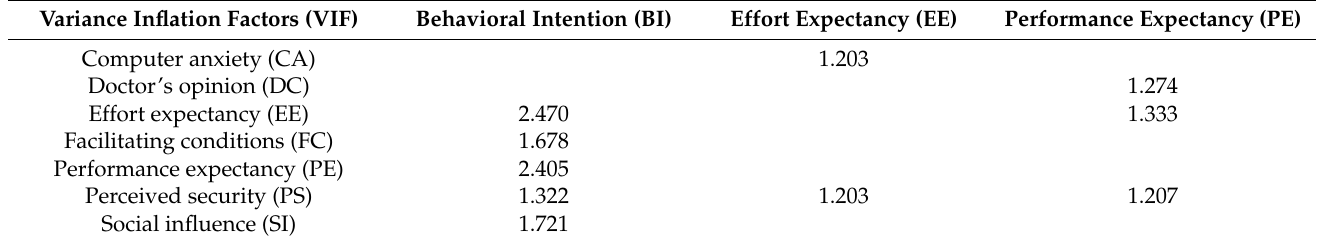
Table A3. Collinearity